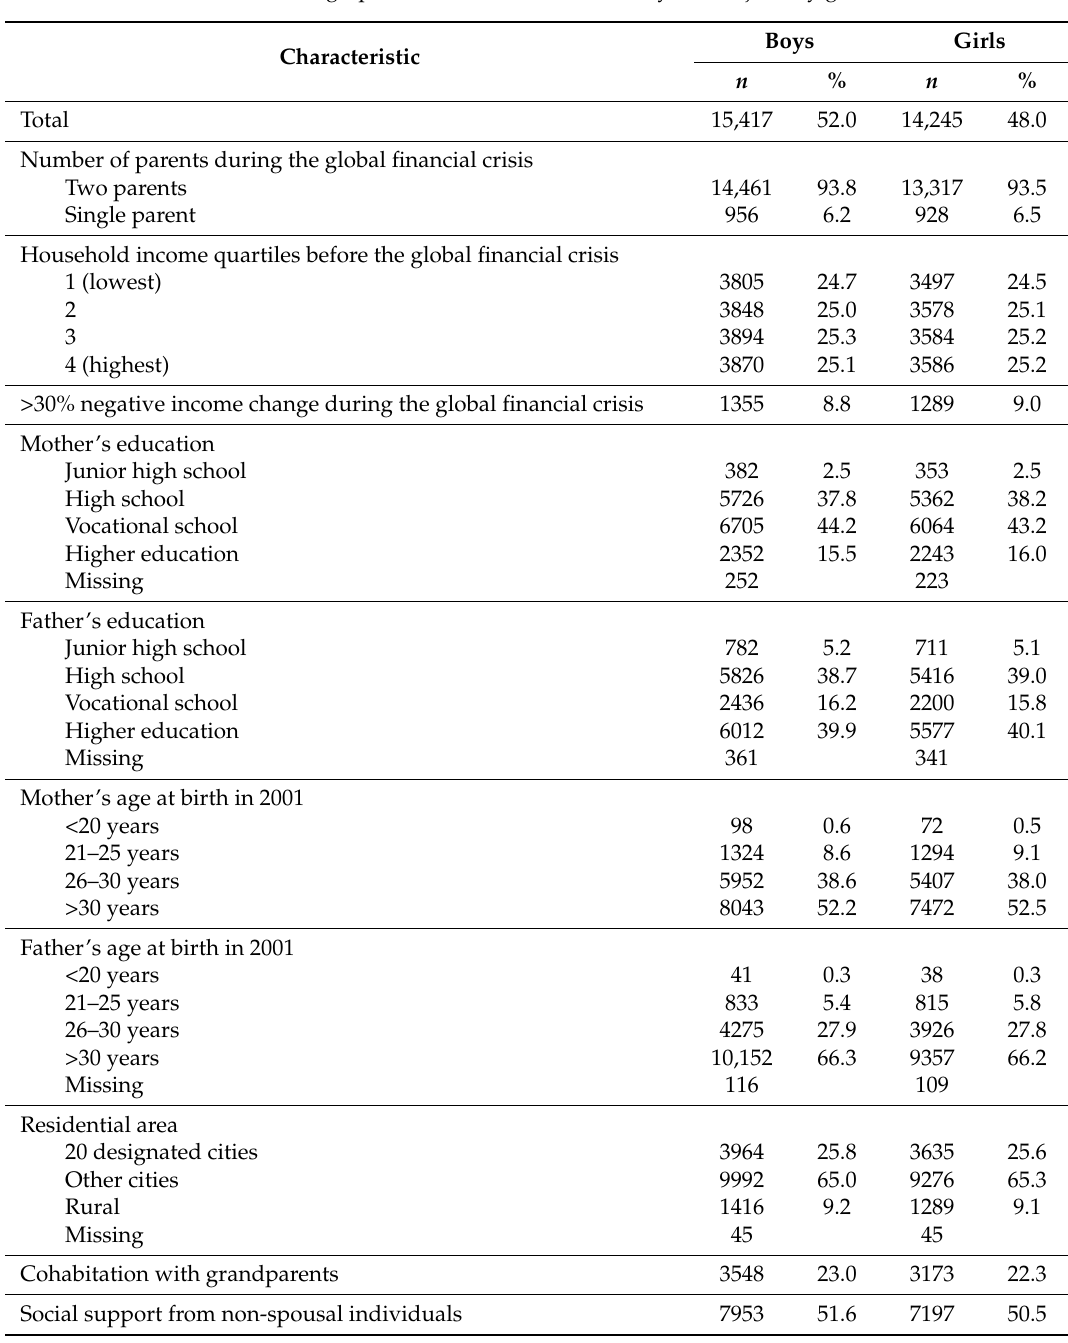
Table 1. Demographic characteristics of the analyzed subjects by